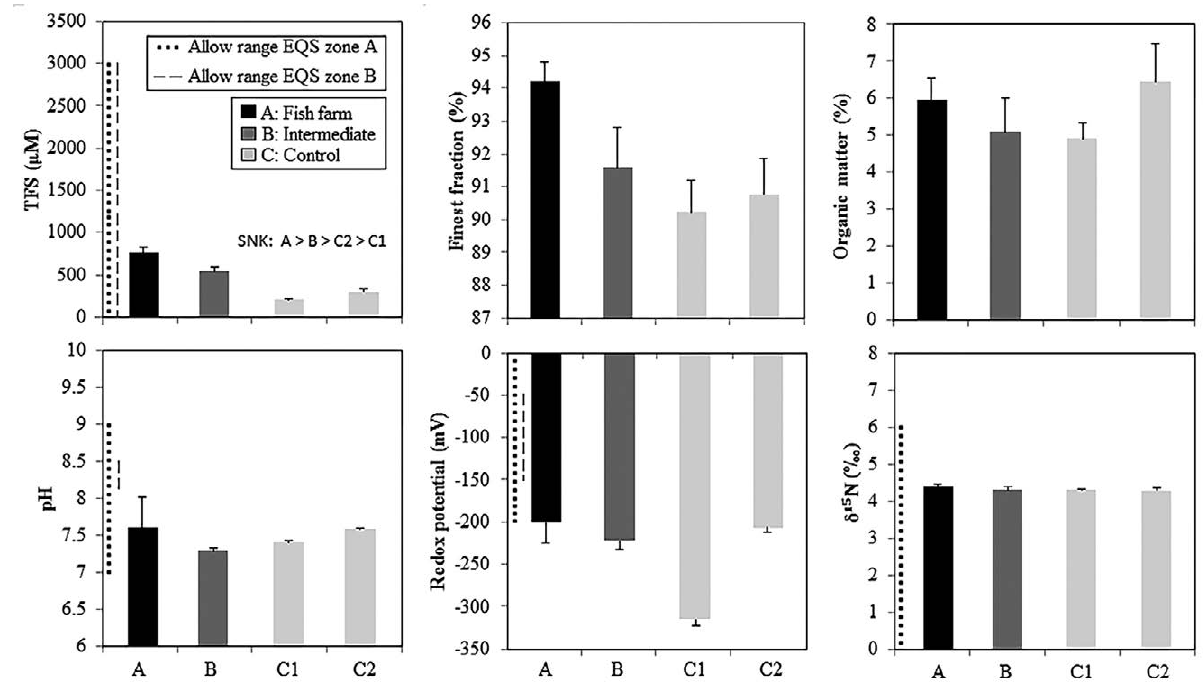
Fig. 2. – Mean values (± standard error) of total free sulphides (TFS), finest fraction (%), organic matter (%), pH, redox potential (mV) and δ 15